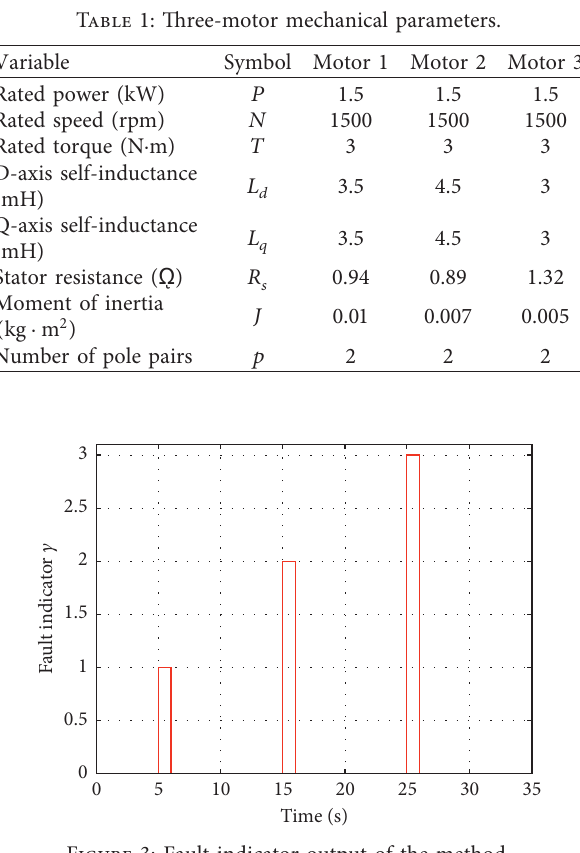
Figure 3: Fault indicator output of the method.